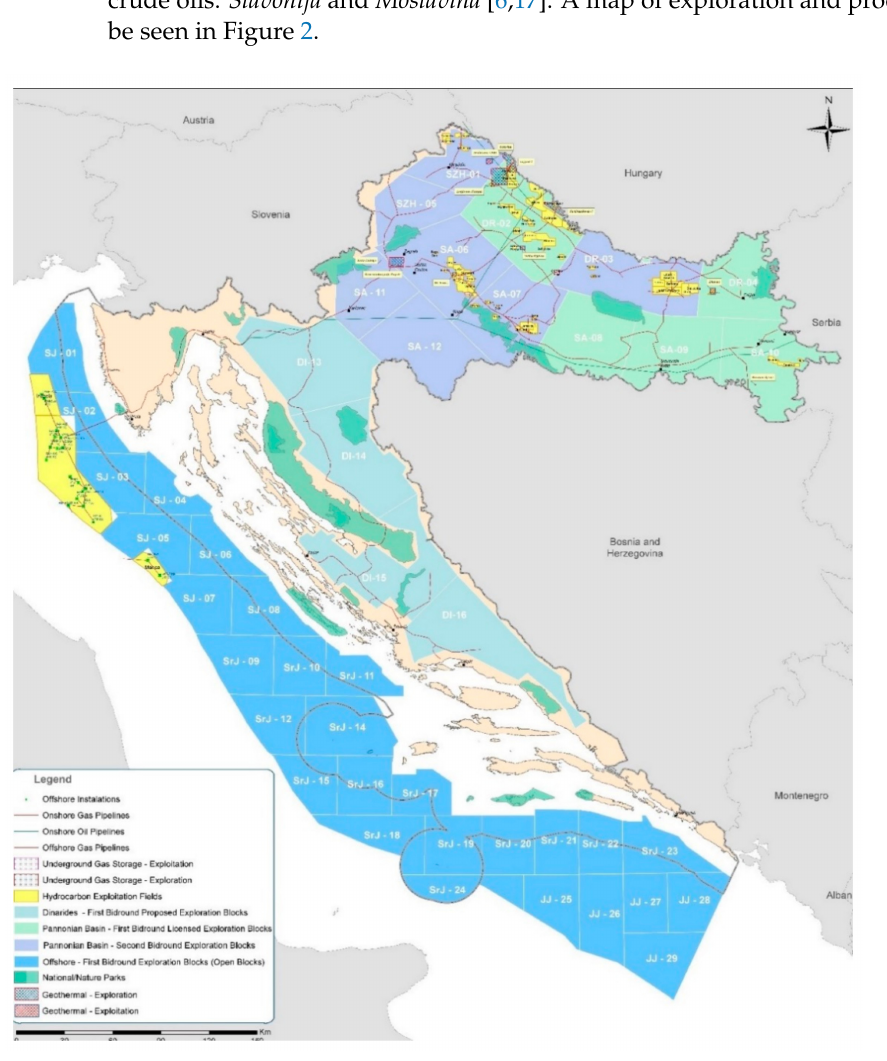
Figure 2. Map of exploration and production blocks in the Republic of Croatia (Provided by CHA,